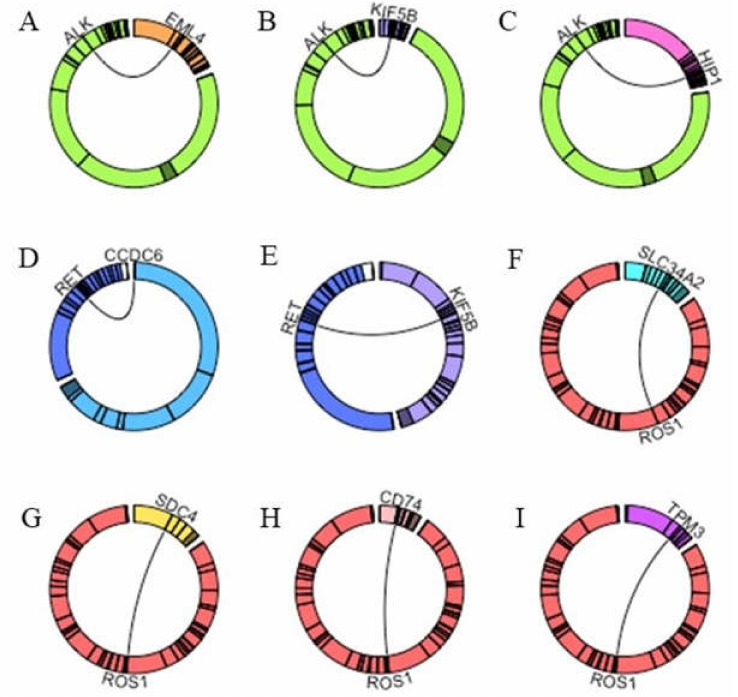
Figure 2. Circos plots representation of the gene fusions reported in routine sample set by using the R circlize package (R Core Team v3.6.1) [32]. ( A – C ) shows ALK translocations and corresponding fusion partners detected in analyzed samples. ( D , E ) shows RET fusions and gene partners identified in sample population. ( F – I ) shows ROS1 translocations and fusion partners inspected in analyzed samples. Abbreviations: ALK : Anaplastic Lymphoma Kinase; CCDC6 : Coiled-Coil Domain Con- taining 6; CD74 : CD74 Molecule, Major Histocompatibility Complex, Class II Invariant Chain; CS: sequence; EML4 : Echinoderm Microtubule Associated Protein Like 4; HIP1 : Huntingtin Interacting Protein 1; KD: kinase domain; KIF5B : Kinesin Family Member 5B; MET : MET Proto-Oncogene, Receptor Tyrosine Kinase; PR: promoter region; RET : Rearranged During Transfection; ROS1 : ROS Proto-Oncogene 1, Receptor Tyrosine Kinase; SD: structural domain; SLC34A2 : Solute Carrier Family 34 Member 2; SDC4 : Syndecan 4; TPM3 :